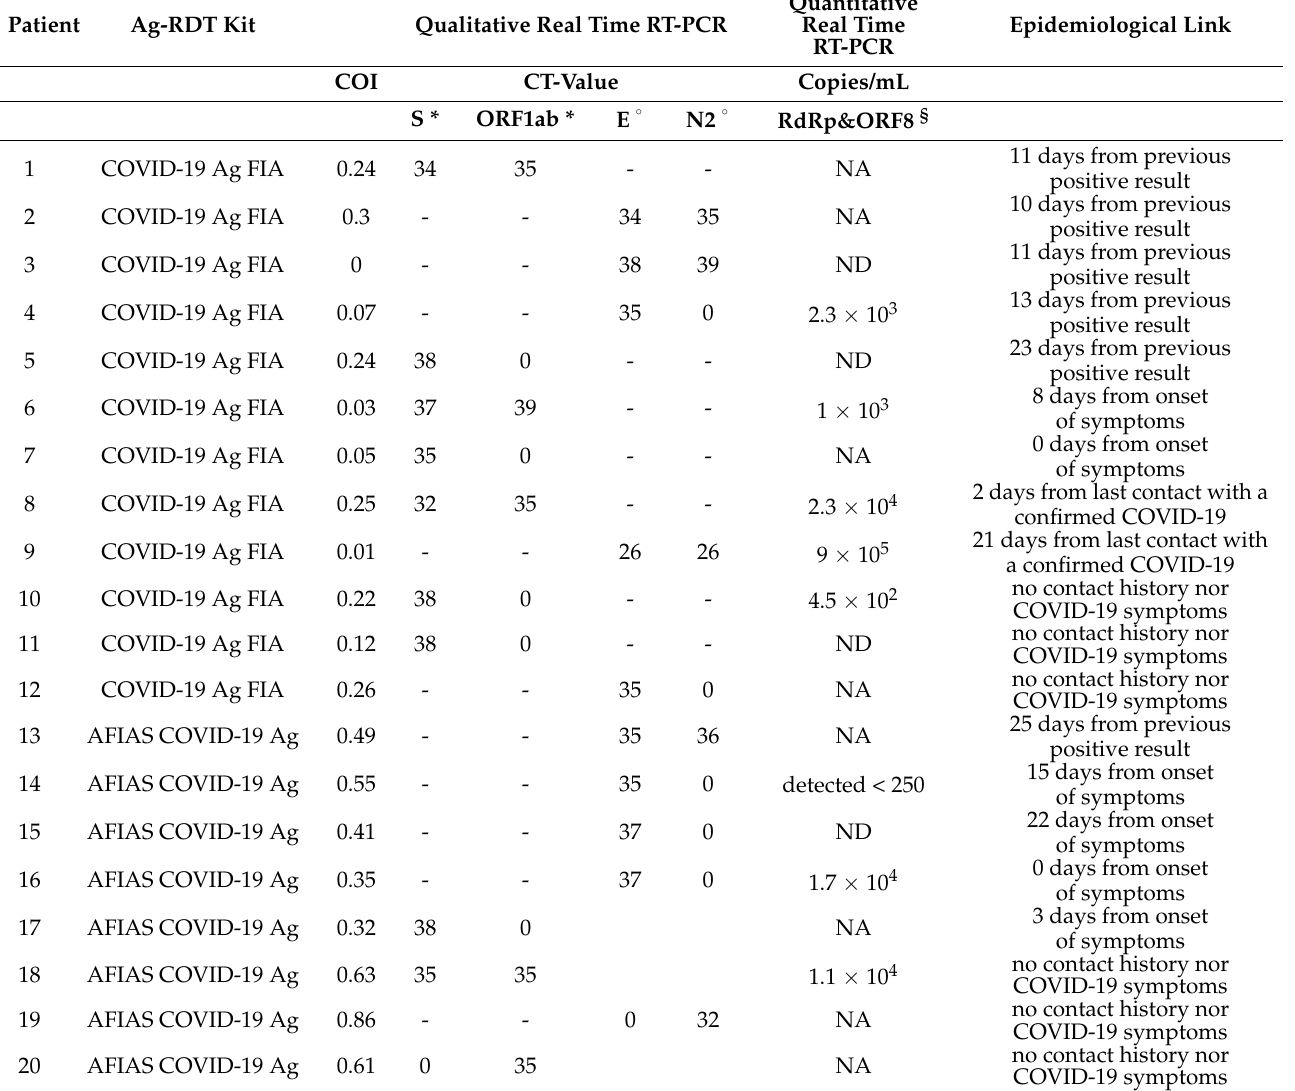
Table 2. Viral loads and epidemiological link of patients with positive qualitative real time RT-PCR and negative Ag-RDTs. Detection of SARS-CoV-2 RNA by quantitative real time RT-PCR analyzing the same specimens used for qualitative real time RT-PCR. The table shows that the patients in which the Ag-RDTs failed to detect the virus have either a previous positive molecular result dating at least 10 days before or no contact history with an index case or are previous COVID-19 patients or have a recent onset of COVID-19-compatible symptoms. NA = not available, ND = not